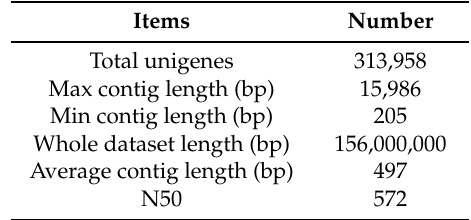
Table 1. Overview of the sequencing and assembly.